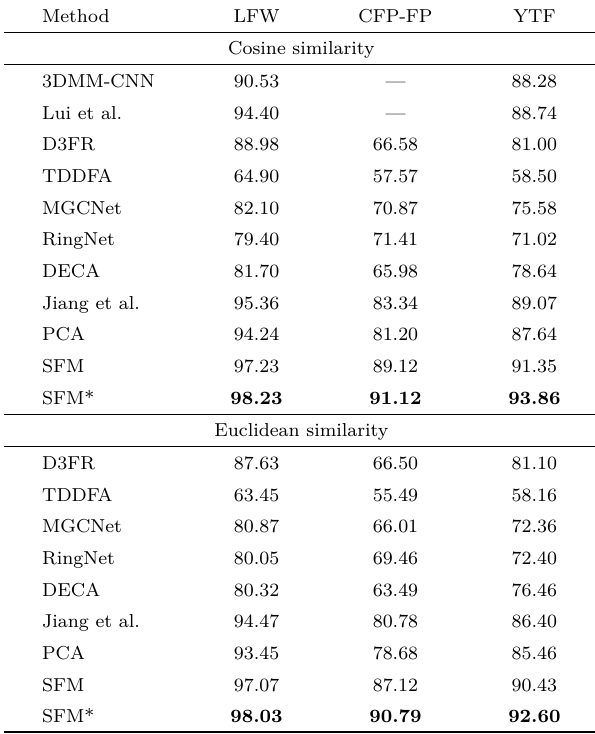
Table 4 Face verification accuracy (%) on the LFW, CFP-FP, and YTF datasets. Our results are obtained using the weighted center